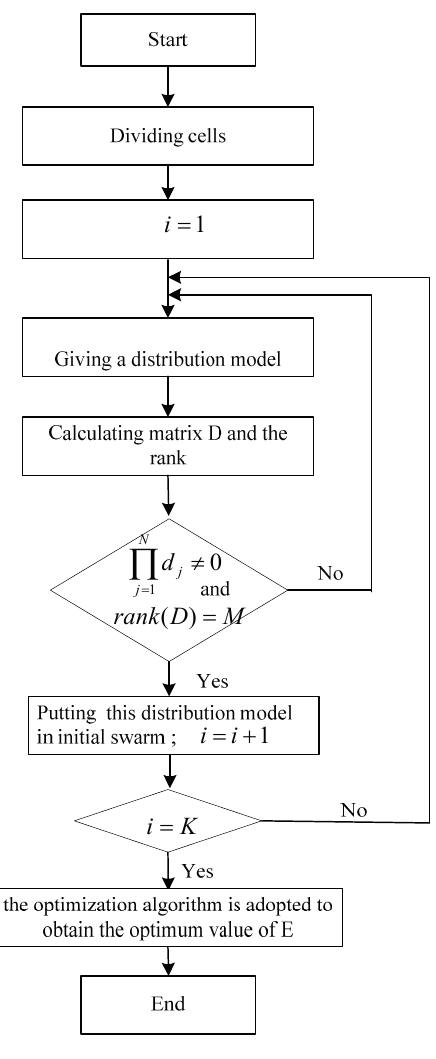
Figure 2. Illustration of evaluation